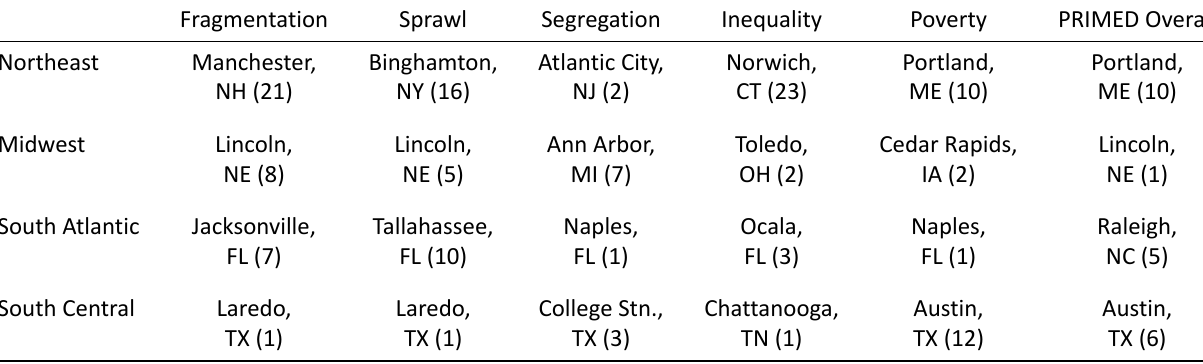
Table 3. Lowest scoring urban regions by census grouping (overall rank in